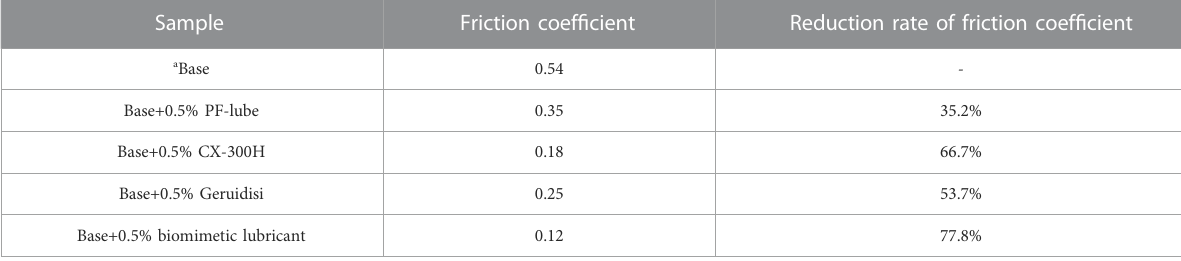
TABLE 7 Performance comparison between a biomimetic wellbore-strengthening PDF and typical oil-based drilling fl uid after a hot-rolling (density is 2.0 g/cm 3 ). Drilling fl uid